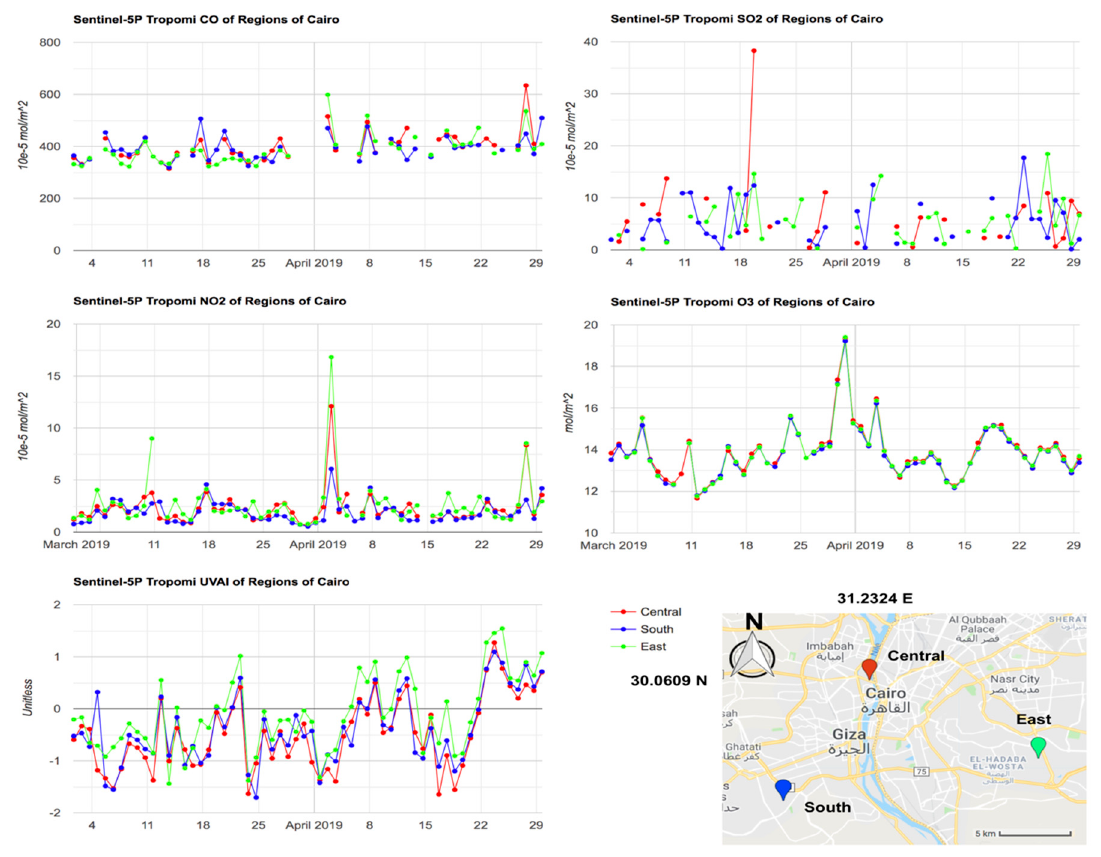
Figure 2. Time series of air quality indicators (CO, SO2, NO2, O3, and UVAI) over three locations within the urban Cairo from March 1 till April 30, 2019. within the urban Cairo from March 1 till April 30,